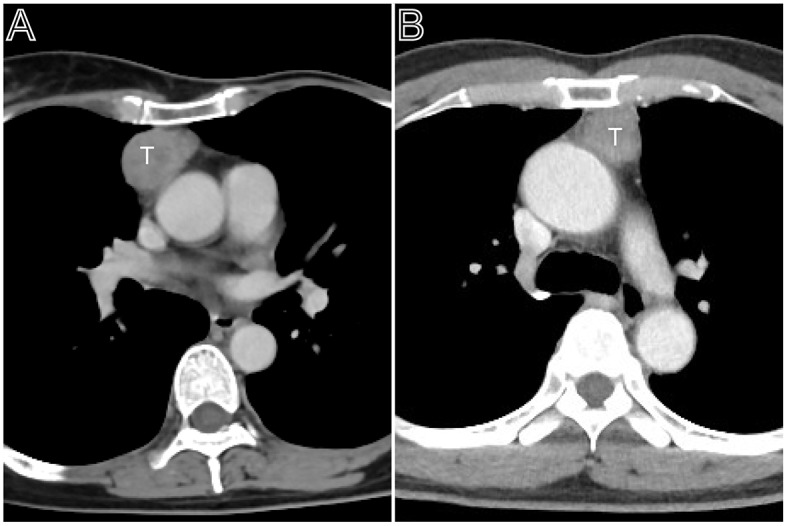
Masaoka–Koga stage II thymomas. (A) Axial contrast-enhanced chest CT image showed a thymoma with a clear contour (Masaoka–Koga stage IIa and WHO classification B1), which was first found at the time of physical examination in a 55-year-old woman. (B) A 50-year-old woman mainly complains of general fatigue and subsequently was confirmed myasthenia gravis. Axial contrast-enhanced chest CT image obtained at the level of the left pulmonary trunk showed a thymoma with a slight lobulated contour (Masaoka–Koga stage IIb and WHO classification AB).